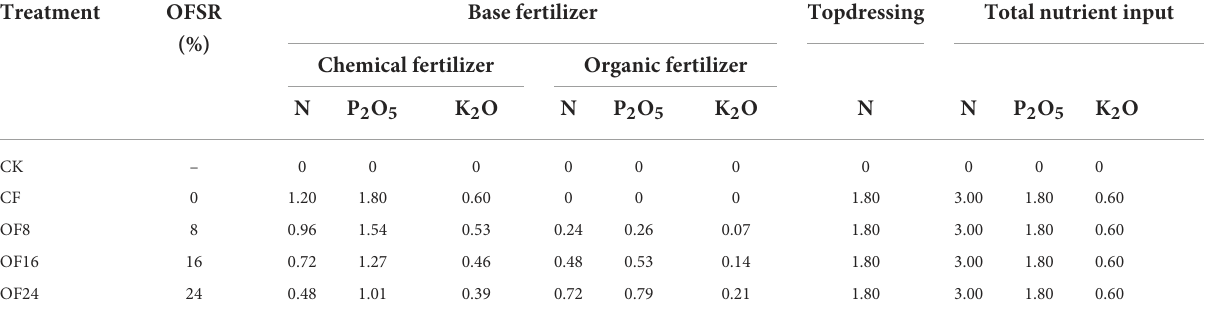
TABLE 1 Fertilization schemes for different treatments (g pot − 1 ).